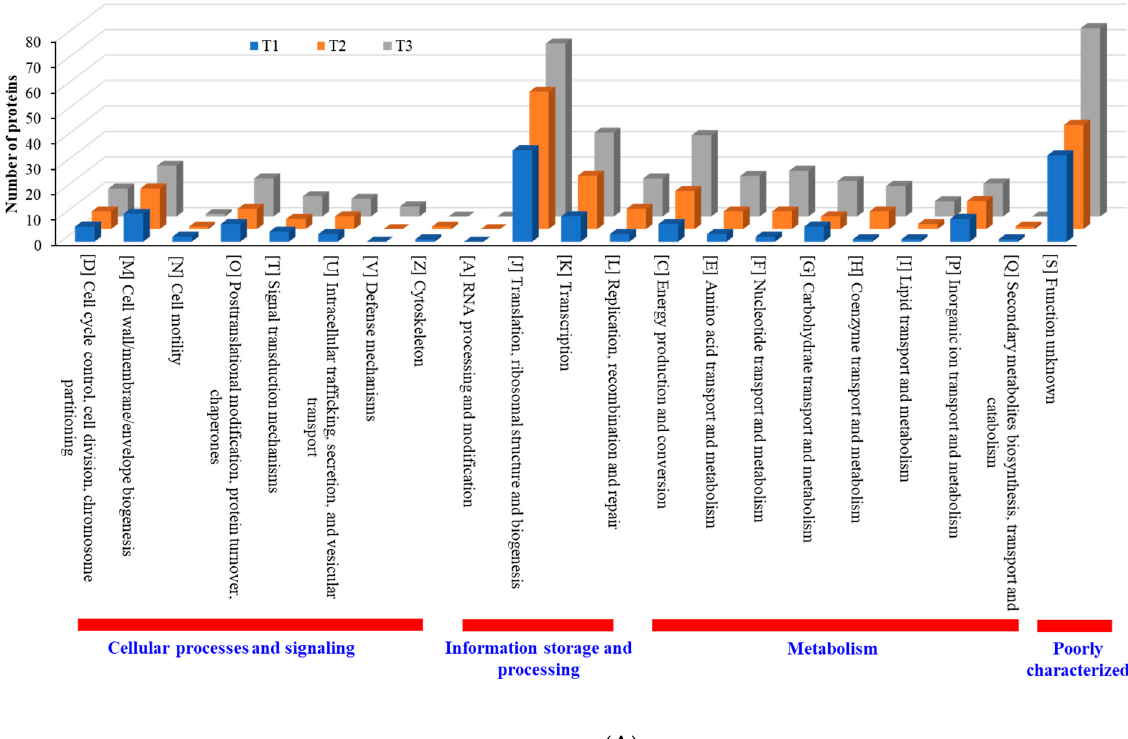
Figure 8. COG functional classification of four major categories in differentially expressed proteins identified from S. epidermidis strain RP62A biofilms grown with sublethal MIC of TC. ( A ): upregulated proteins, ( B ): downregulated proteins, T1: 1/8 MIC, T2: 1/4 MIC, T3: 1/2 MIC.